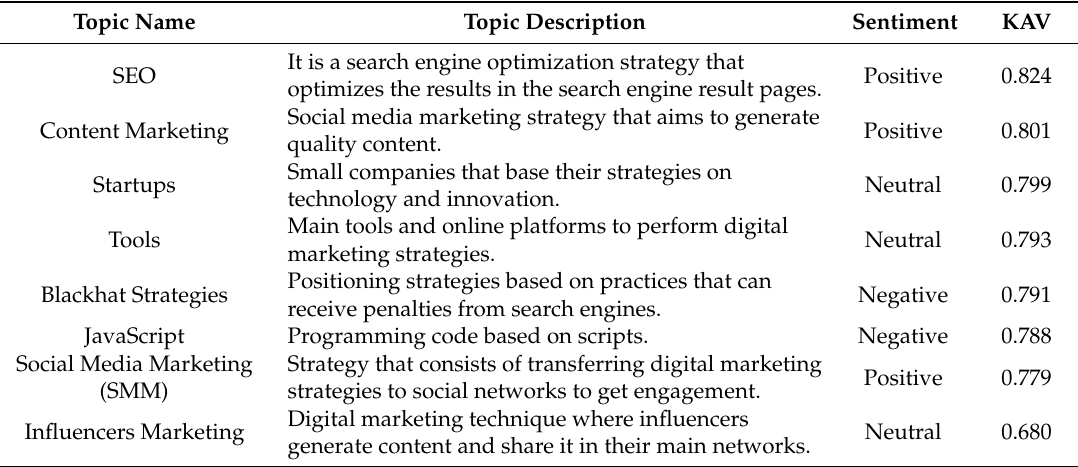
Table 2. Topics identified by the LDA